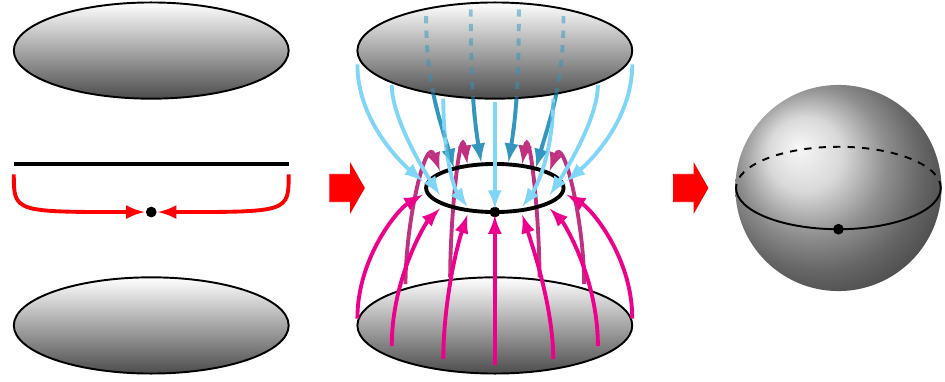
Figure 13. A different cellular decomposition of the sphere.